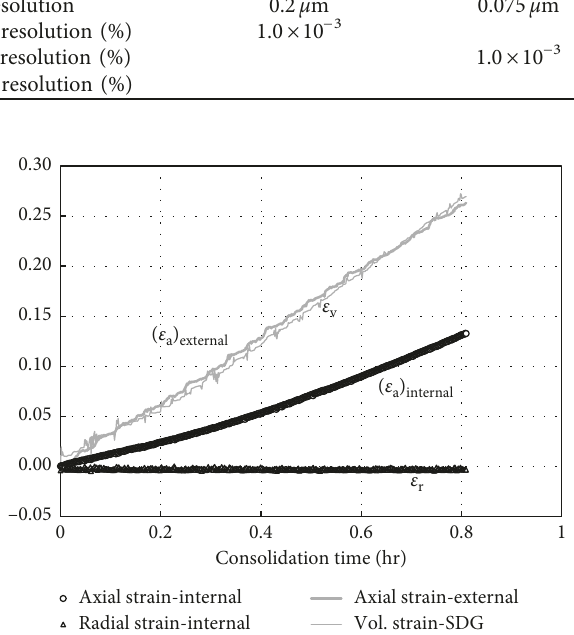
0 consolidation.